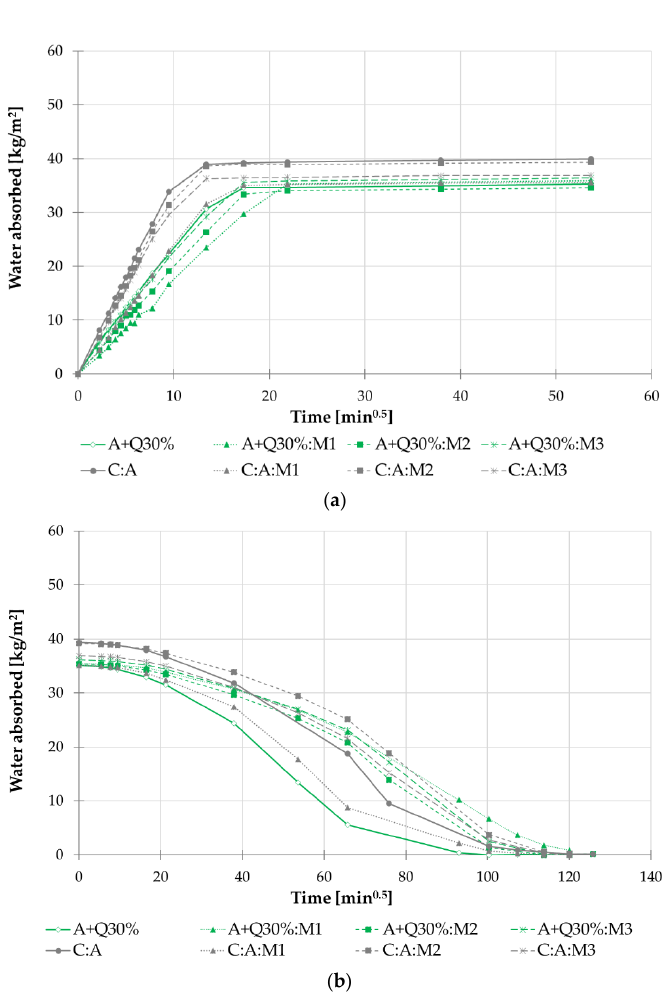
Figure 10. Capillary water absorption curves of the mortars with fine-tuning of the aggregate, at 90 days: ( a ) water absorption; ( b ) water desorption.